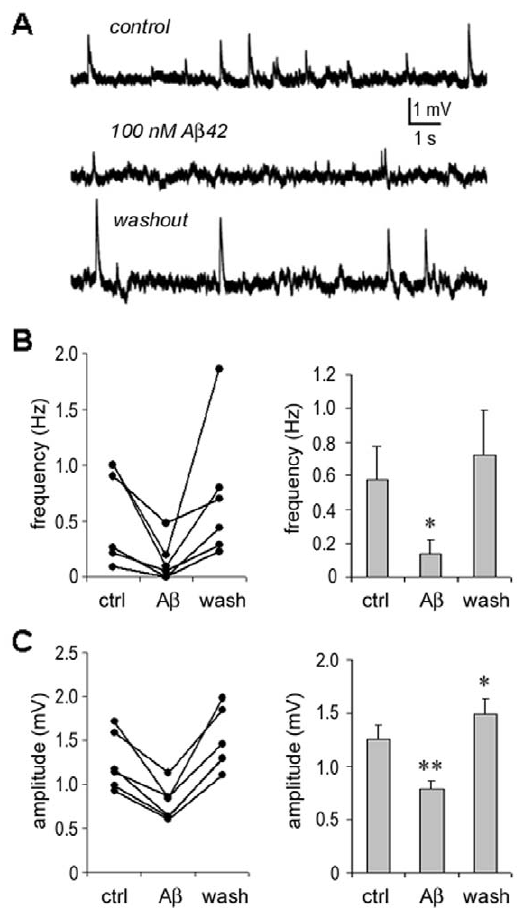
Figure 6. Inhibition of spontaneous subthreshold responses by A b 42. A. Under calcium-free conditions, spontaneous subthreshold responses were recorded from a PC (upper panel). Responses were notably inhibited when 100 nM A b 42 was applied for 10 min. (middle panel), and recovered following a 10 min. washout (lower panel). B. Statistical analysis: The frequency of spontaneous subthreshold activity was significantly reduced by applying intermediate doses of A b 42 ( p= 0.025, n =6) and recovered on washout ( p= 0.445). C. Statistical analysis: The amplitude of spontaneous responses was significantly reduced by applying A b 42 ( p= 0.004) and increased on washout ( p= 0.001). Note: ‘‘*’’, p , 0.05; ‘‘**’’, p , 0.01.